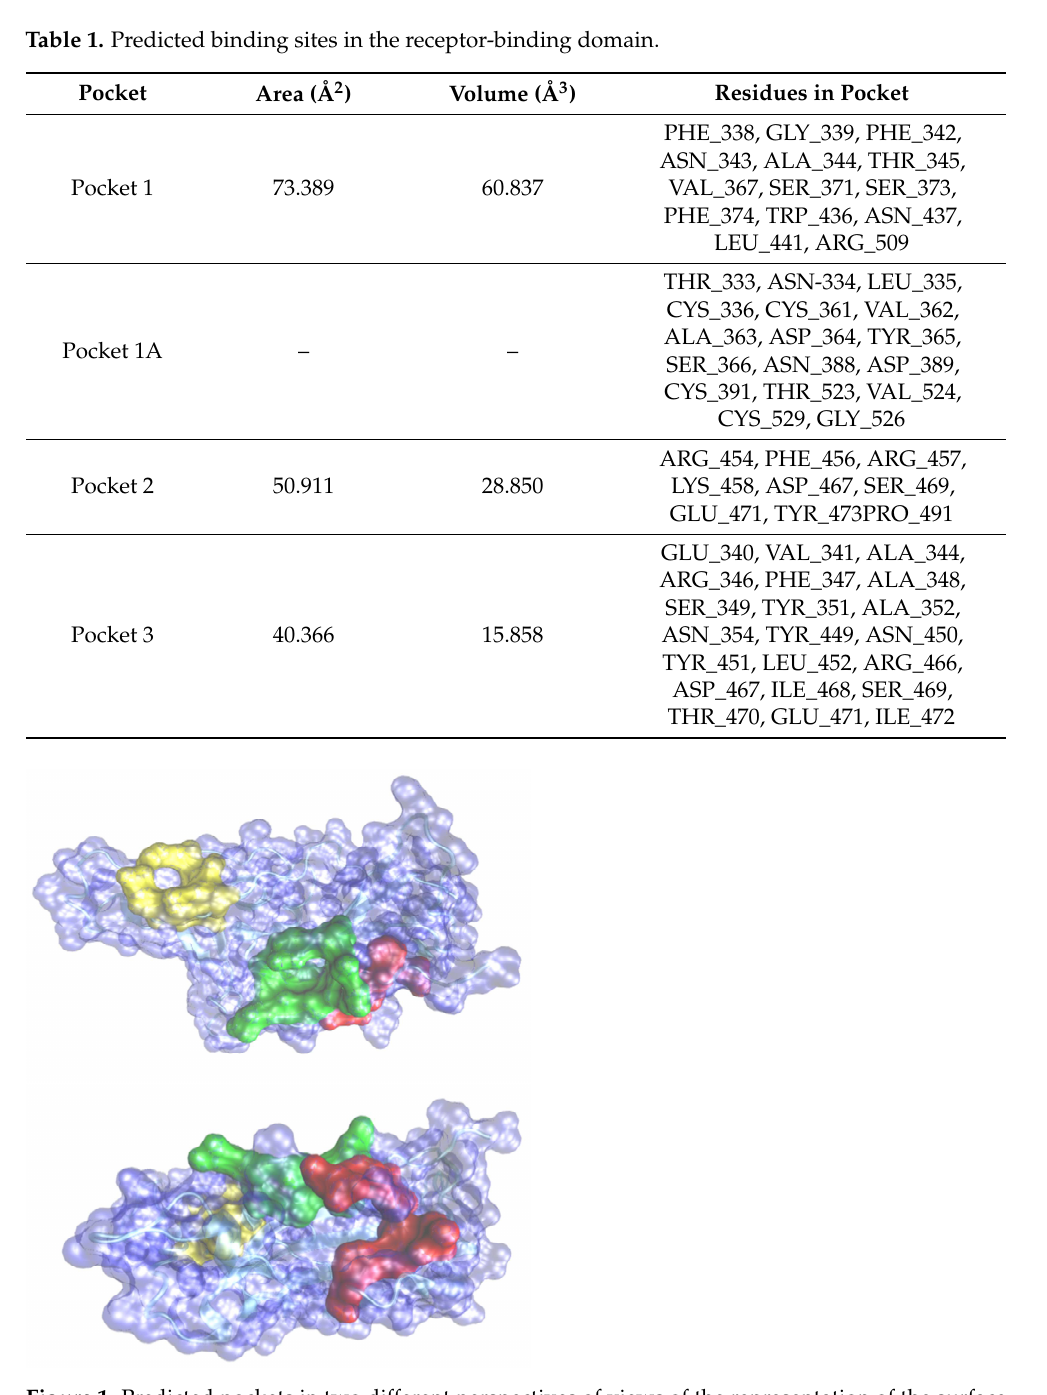
Table 1. Predicted binding sites in the receptor-binding domain.